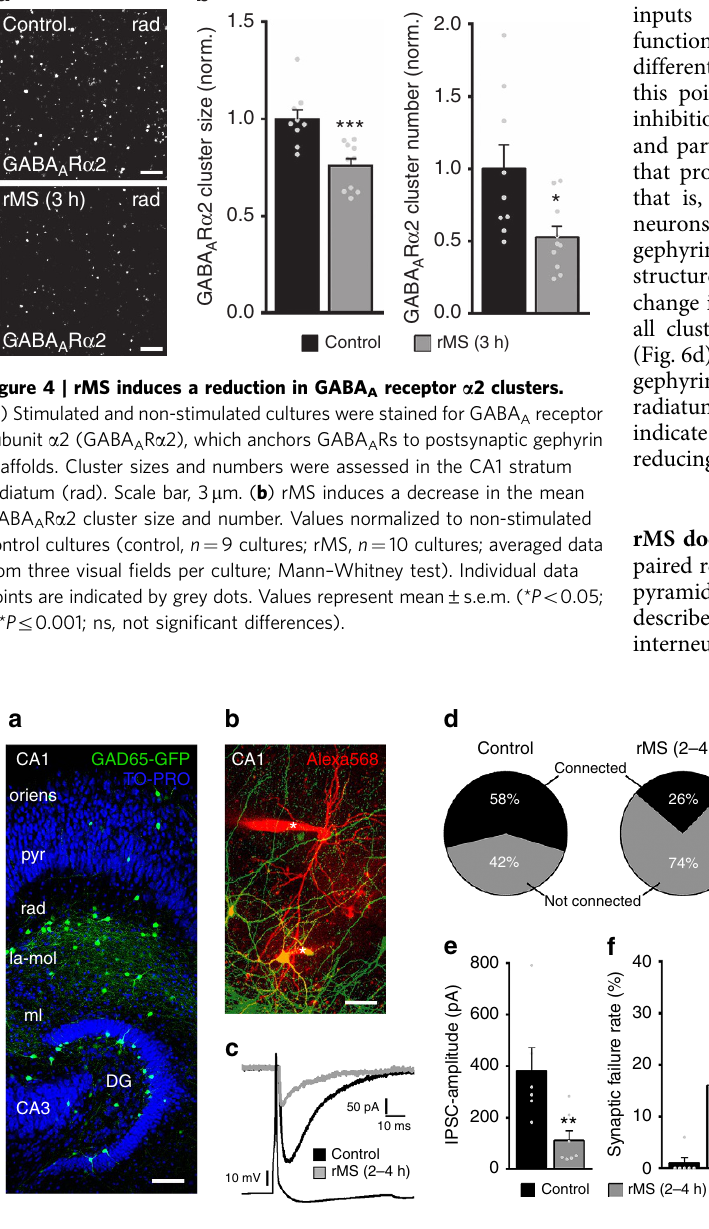
Figure 5 | Paired recordings disclose changes in inhibitory synaptic strength, efficacy and connectivity following rMS. ( a ) Overview of a slice culture